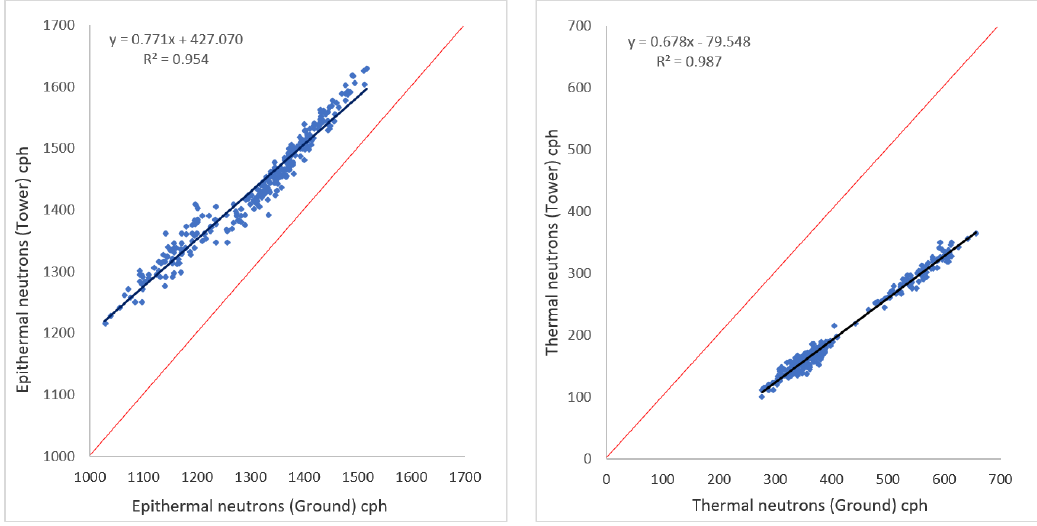
Figure 7. Scatterplots of the ground and tower epithermal and thermal neutrons in the Two-Streams Catchment.